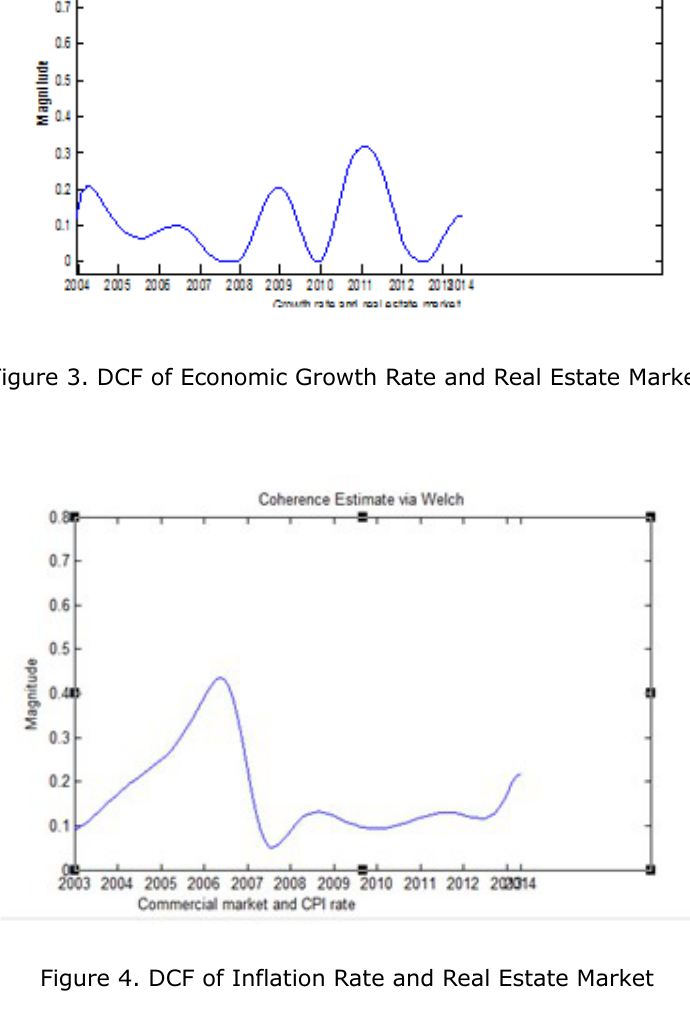
Figure 4. DCF of Inflation Rate and Real Estate